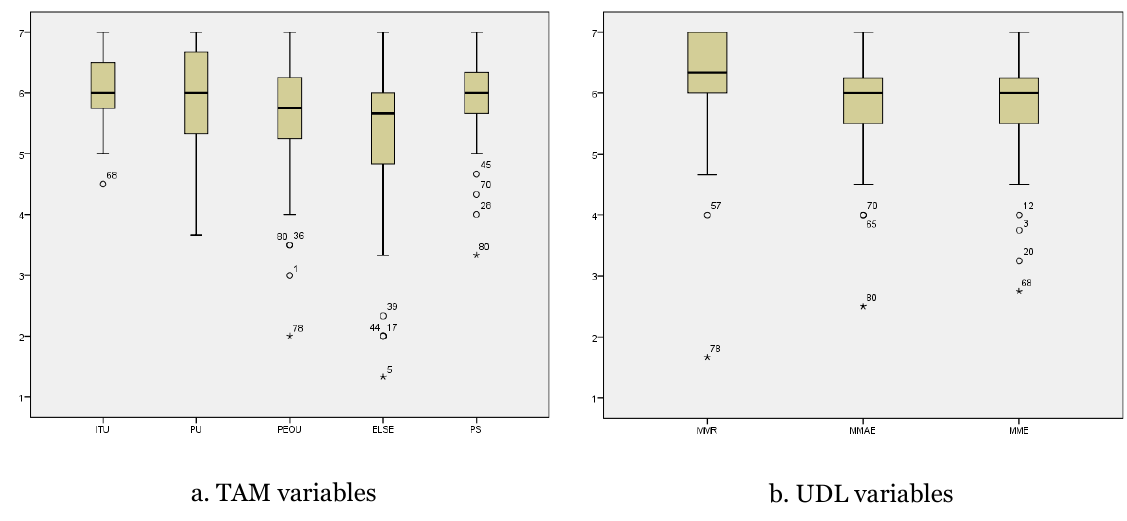
Figure 4. Box plot of the model